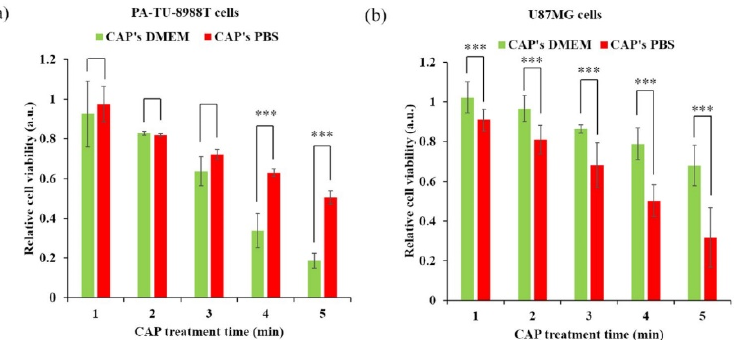
Figure 4. The PTS composition affects its extent of cytotoxicity. ( a ) Pancreatic cancer cell line PA- TU-8988T. ( b ) Glioblastoma cell line U87MG. Student’s t -test was performed and the significance is indicated as *** p < 0.005. Reproduced from [58] . Copyright 2017 Springer Nature.